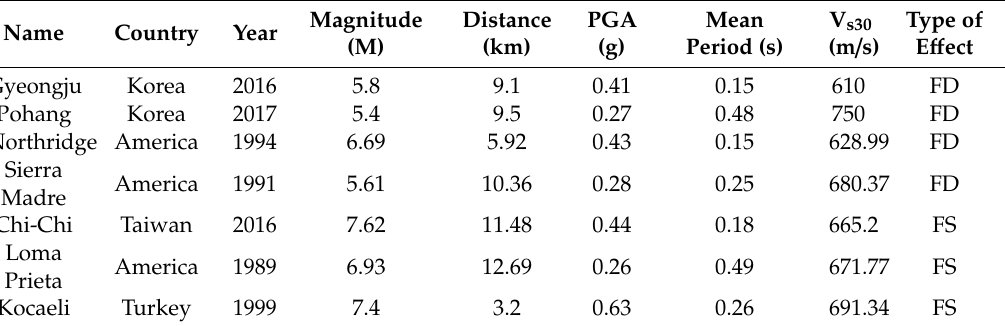
Table 1. List of near-fault ground motions.